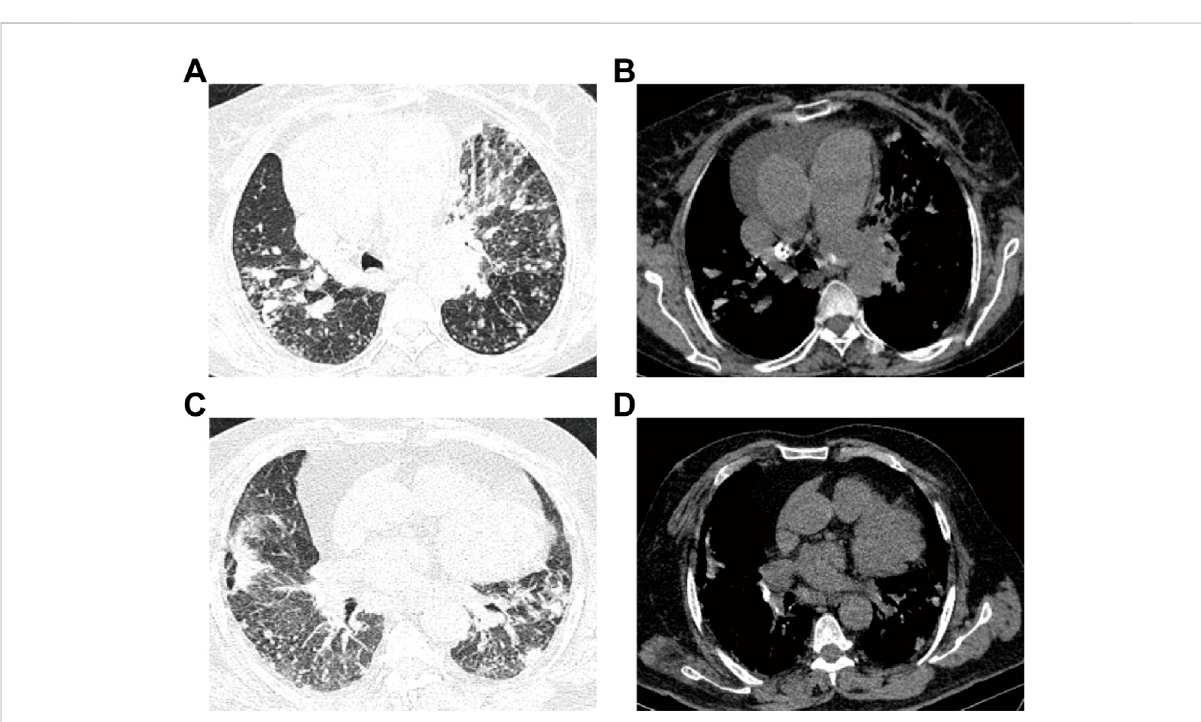
FIGURE 2 Images for ATB and non-ATB. (A – B) Patient with active pulmonary TB: male, 60-years-old, chest pain and dyspnea for 3 days, multiple central lobular nodules in the right lower lobe, left upper lobe and left lower lobe, and with cords and surrounding patchy dense shadowing. (C – D) Patient with non-active pulmonary TB: female, 50-years-oldwho experienced cough and sputum for 6 days, with multiple patchy shadows observedin the middle lobe of the right lung and the lower lobes of both lungs, adjacent to the pulmonary nodules and surrounded by tree